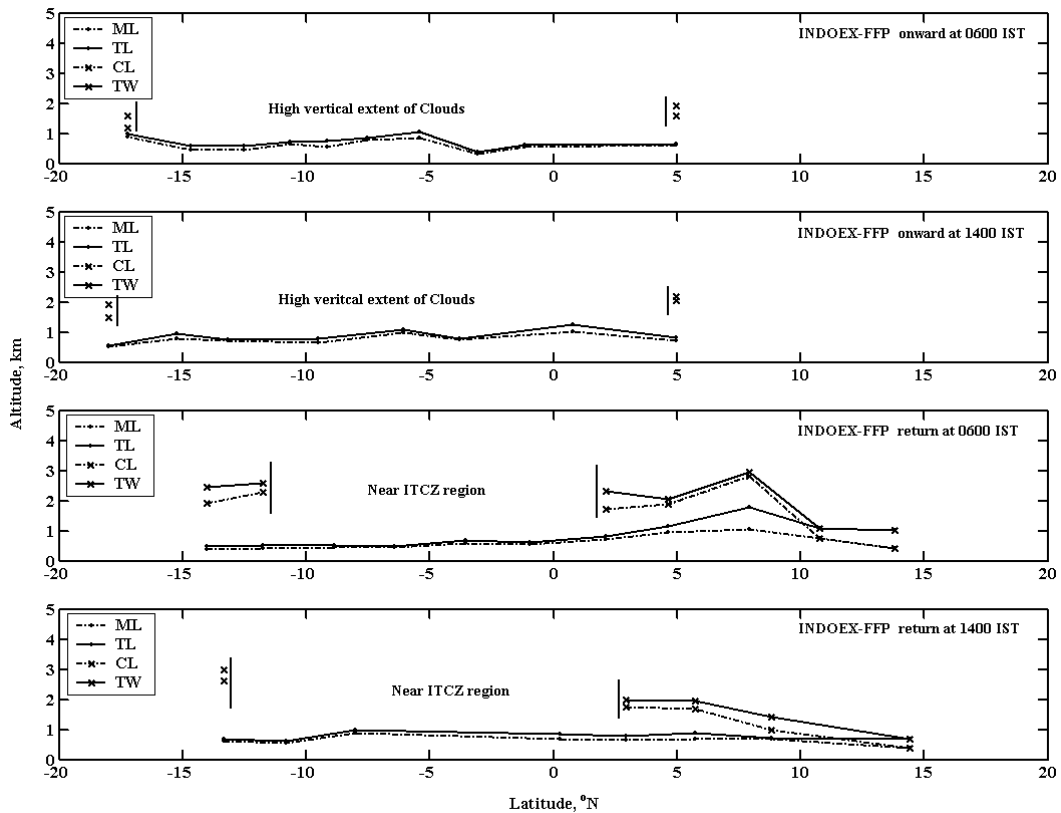
Fig. 8. Latitudinal variation of Mixed Layer (ML) height, Transition Layer (TL) height, Cloud Layer (CL) and Trade Wind inversion (TW) heights during INDOEX-FFP. The continuous and dotted lines joined with the dot symbol represent the TL height and ML height, respectively. The continuous and dotted lines joined with the cross symbol represent TW height and CL height,